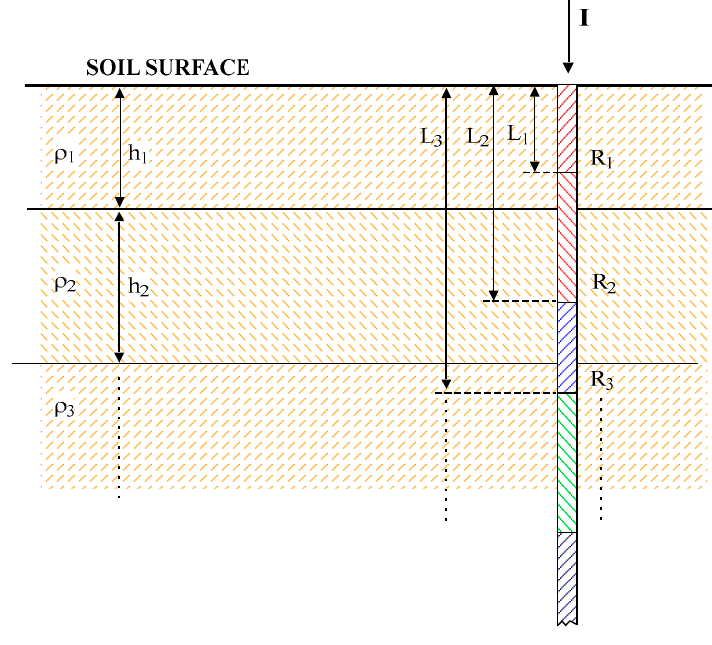
Figure 1. Outline of the RDR method.